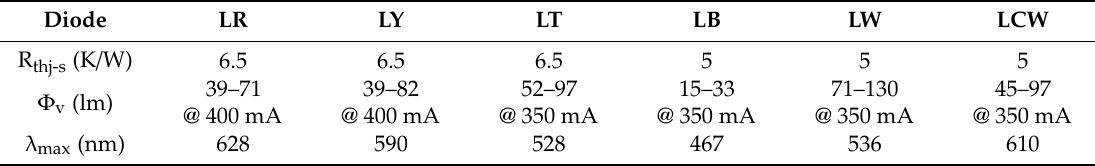
Table 1. Values of selected exploitation parameters of the tested